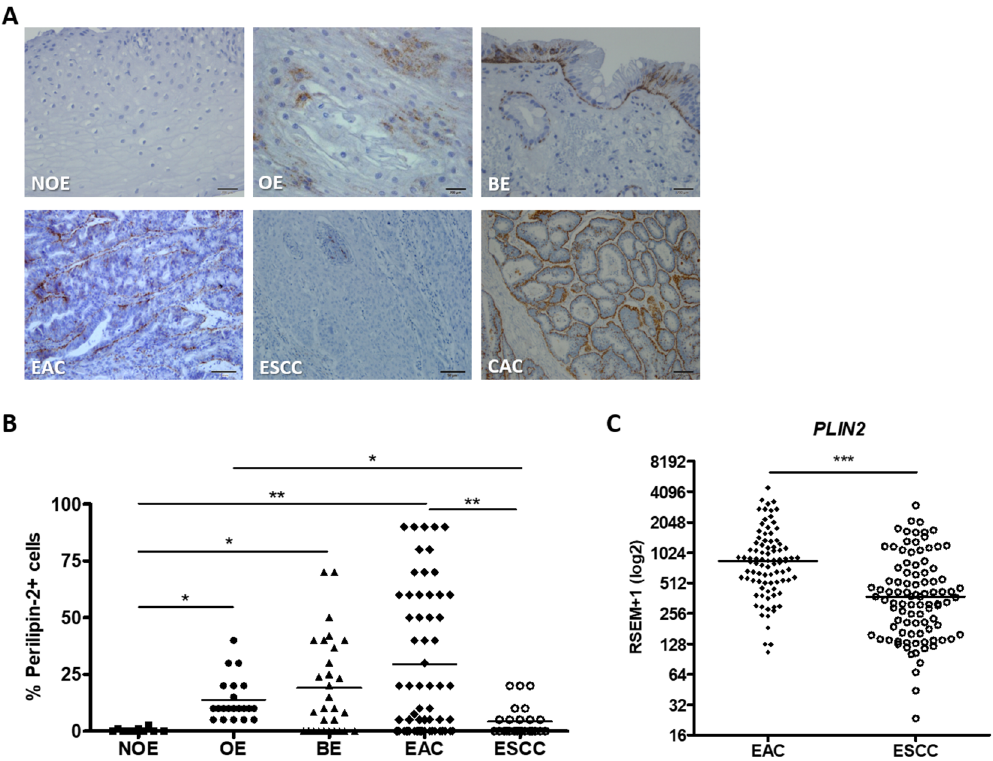
Figure 1. Perilipin-2 expression pattern in esophageal samples. ( A ) Representative immunohistochemistry micrographs of esophageal samples from non-obese individuals (NOE; n = 10), obese individuals (OE; n = 21), Barrett’s esophagus (BE; n = 30), esophageal adenocarcinoma (EAC; n = 64) and esophageal squamous cell carcinoma (ESCC; n = 25) patients stained for Perilipin-2. Colon adenocarcinoma (CAC) samples were used as positive control for Perilipin-2 staining. ( B ) Graphical representation of the esophageal samples’ Perilipin-2 staining score. ( C ) PLIN-2 mRNA expression evaluated in 88 EAC and 95 ESCC samples, from patients whose data is available at TCGA database. Gene expression pattern is evaluated from RNA-seq data, and represented as RSEM-1 units *p < 0.05; **p < 0.005; ***p <